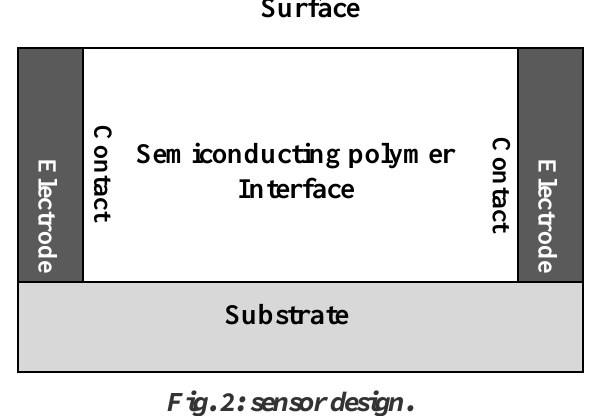
Fig. 2: sensor design.